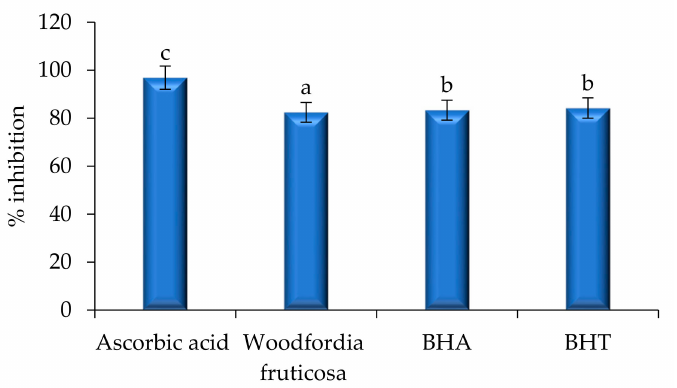
Figure 8. Antioxidant activity of Woodfordia fruticosa flower’s dry extract in comparison with natural and synthetic commercially available antioxidant components. Data are presented as means ± SEM ( n = 3); a–c: Means within the column with different lowercase superscripts are significantly different ( p <